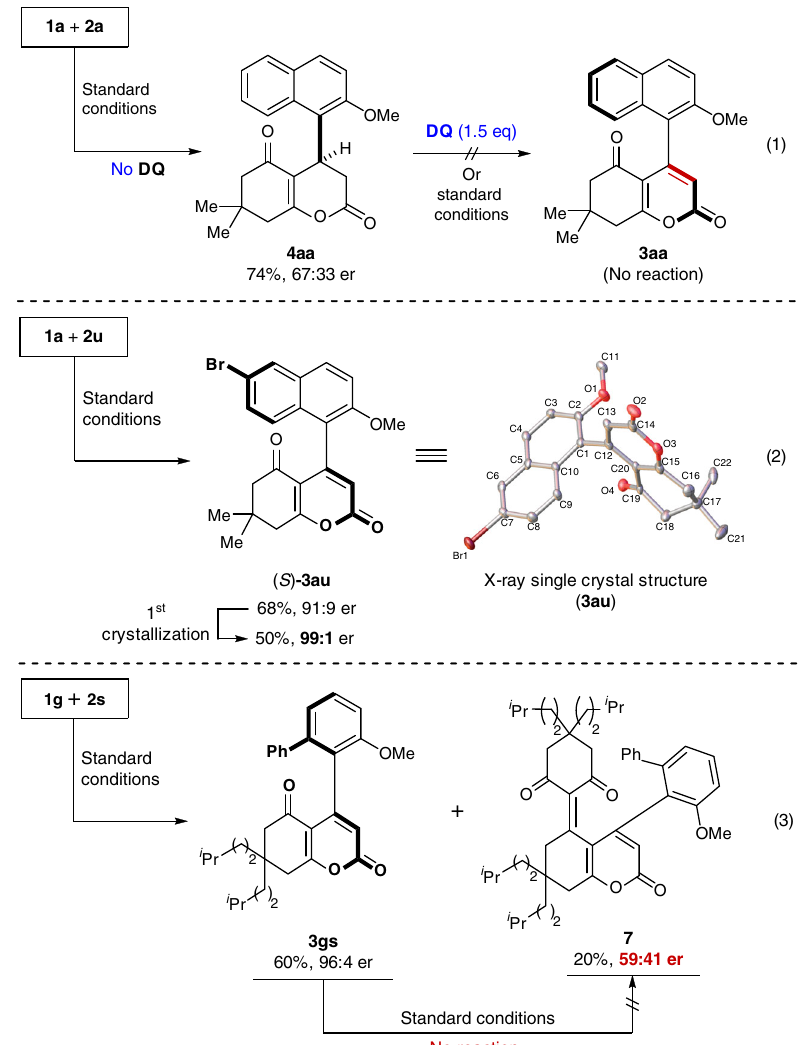
Fig. 7 Control experiments. (1) 4aa failed to undergo oxidation to form 3aa in the presence of DQ. (2) The absolute con fi guration of 3au was determined to be ( S ) by X-ray crystallography. (3) Under standard conditions, the reaction of 1g with 2s yielded 3gs and 7 . However, we found that 7 was not directly generated from 3gs under currrent conditions